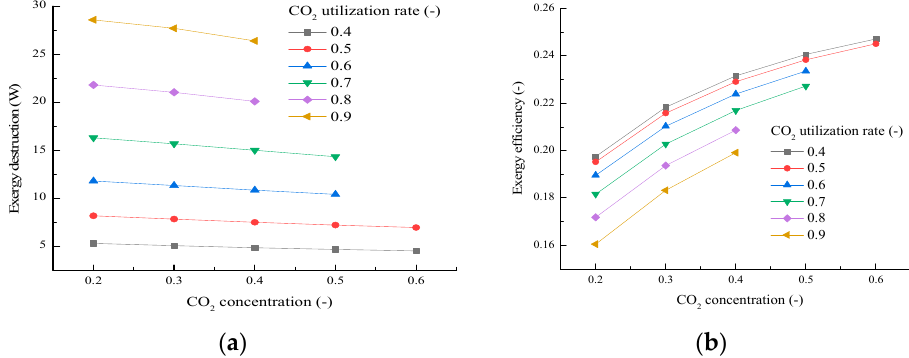
Figure 13. Exergy destruction ( a ) and exergy efficiency ( b ) for different CO 2 concentrations and different cathode CO 2 gas utilization rates.